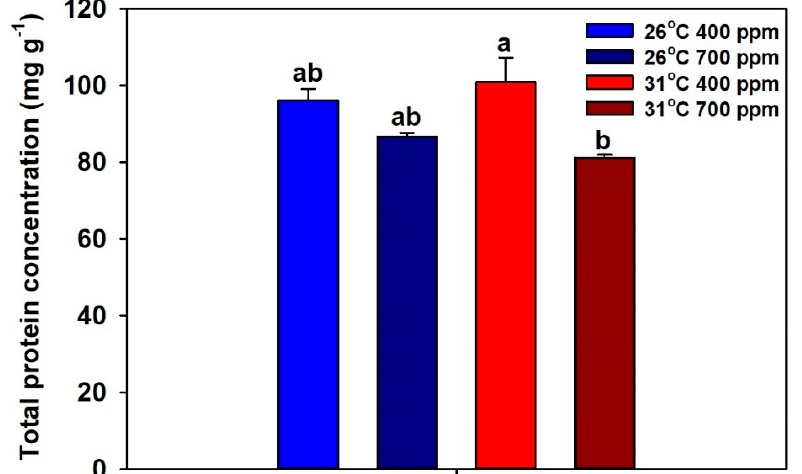
Figure 4. The effects of ambient (400 ppm) vs. elevated (700 ppm) CO 2 and near-optimal (26 °C) vs. chronic warming (31 °C) daytime temperatures on whole-plant total-protein concentration of Triticum aestivum cv. Glenn labeled with 1 mM NH 4 15 NO 3 . Each bar represents mean ( n = 4) + 1 SEM. Within each panel, bars not sharing the same letters are significantly di ff erent ( p < 0.05, Tukey’s